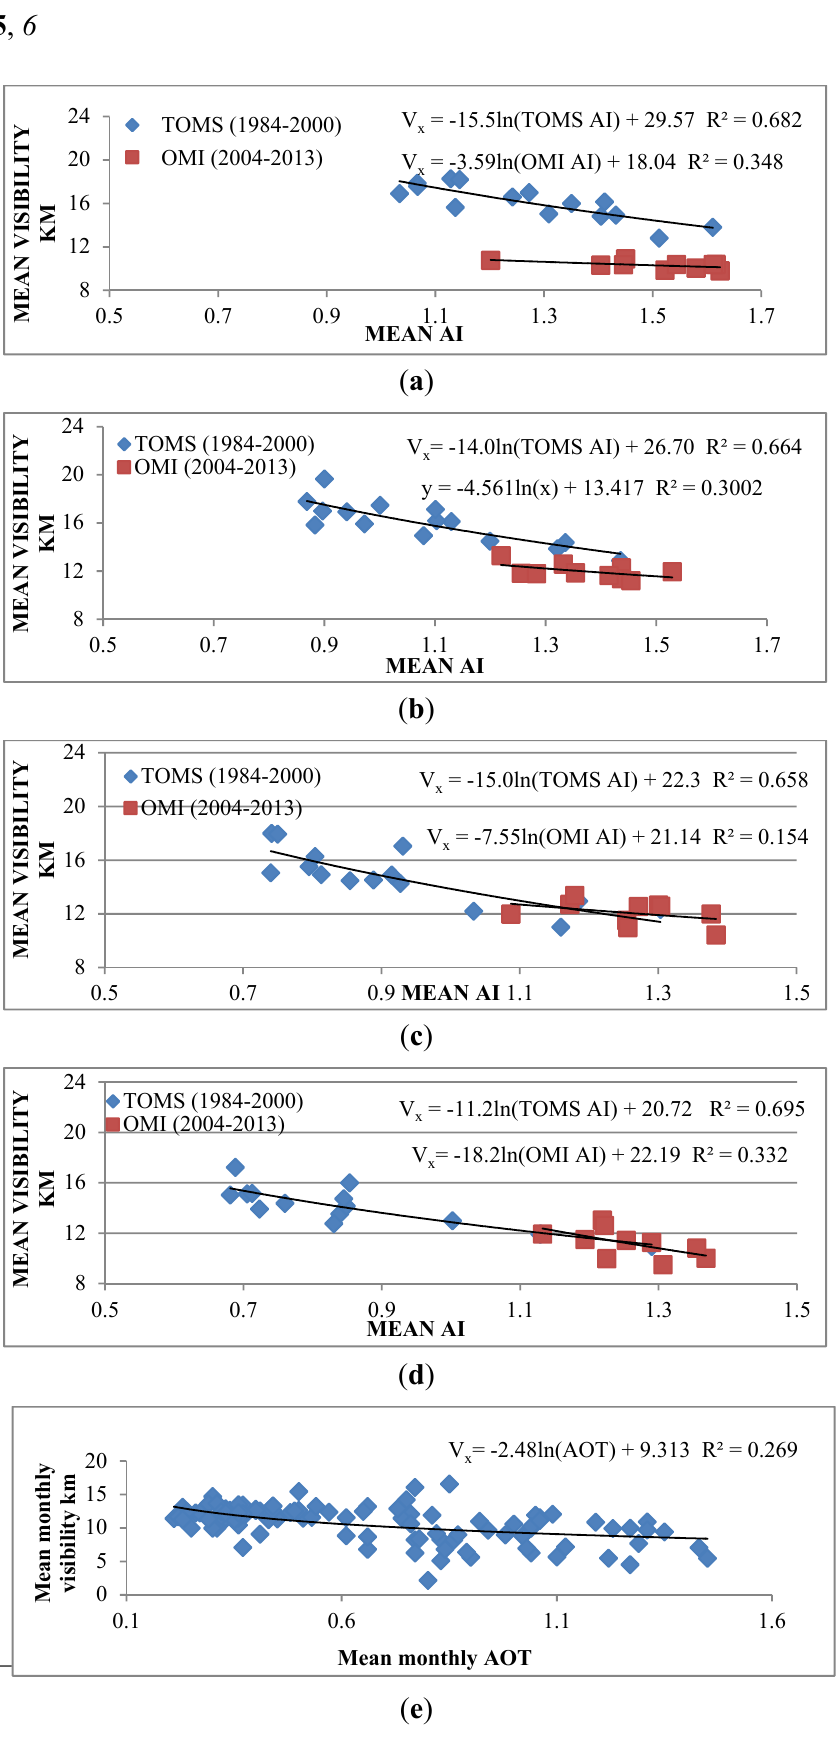
Figure 9. Correlation between visibility (V x ) and Aerosol Index (AI). ( a ) Sahel, ( b ) North central, ( c ) Southern, ( d ) Coastal zones of Nigeria, ( e ) Visibility V x and AOT over